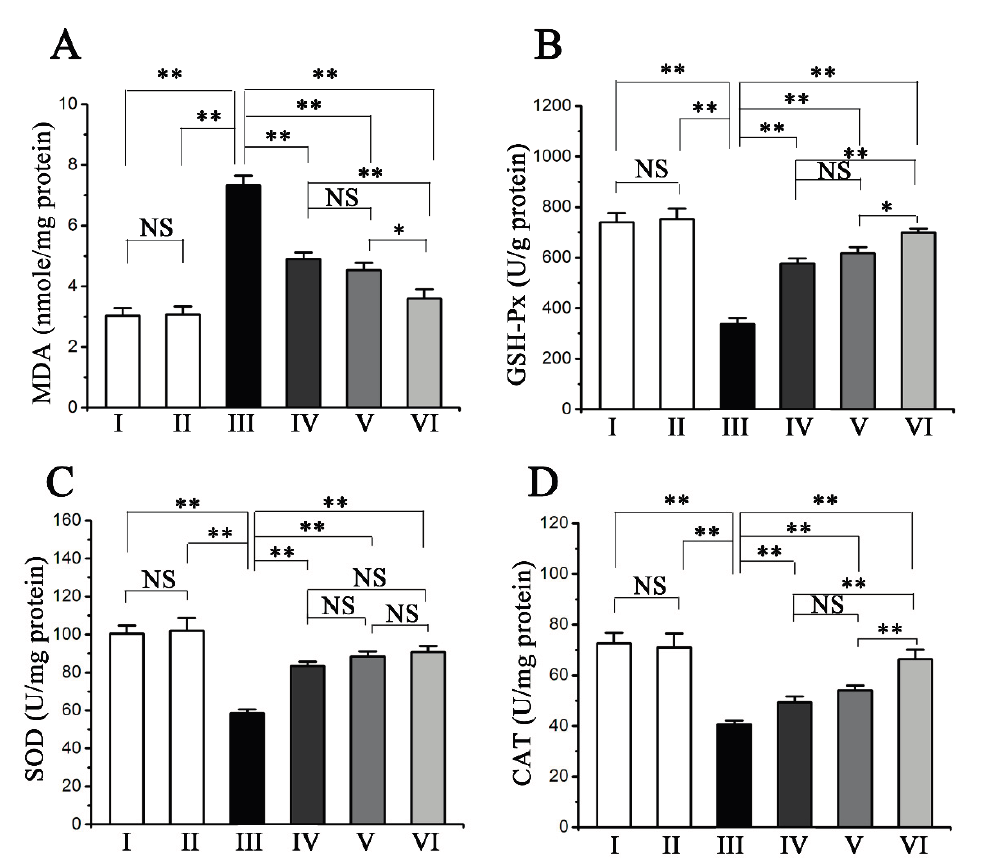
Figure 2. Pretreatment effects of procyanidin B2 on CCl 4 -induced lipid peroxidation production MDA ( A ); and the activities of antioxidant enzymes GSH-Px ( B ); SOD ( C ); and CAT ( D ) in the livers. Animals were divided into following groups: I, normal control; II, procyanidin B2 control; III, model; IV, procyanidin B2 (25 mg·kg − 1 ) + CCl 4 ; V, procyanidin B2 (50 mg·kg − 1 ) + CCl 4 ; and VI, procyanidin B2 (100 mg·kg − 1 ) + CCl 4 .